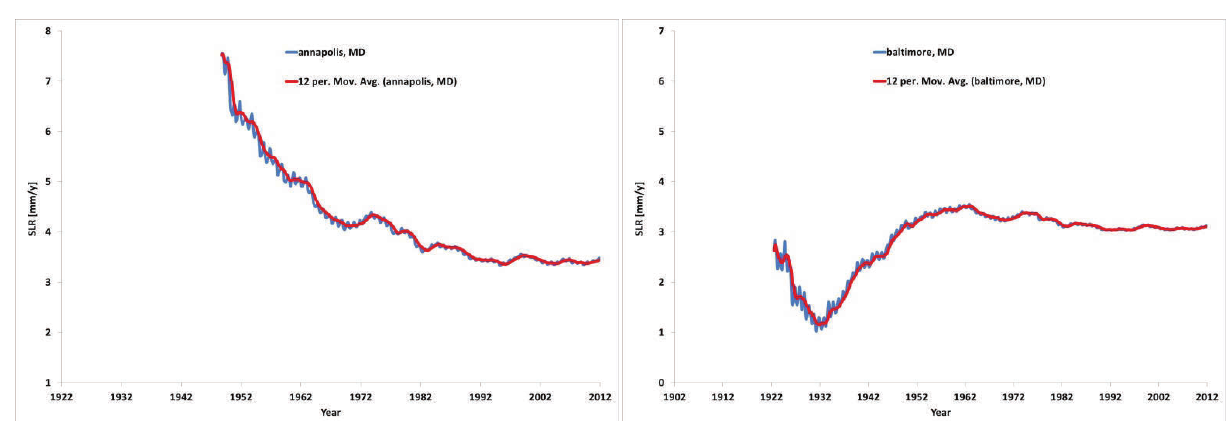
Figure 5. SLR A trend for the 6 stations in Maryland, Virginia and District of Columbia with more than 65 years of recording at the present time. These values are about constant over the last 3 decades ruling out the presence of accel- eration. (data from [12]; pictures from